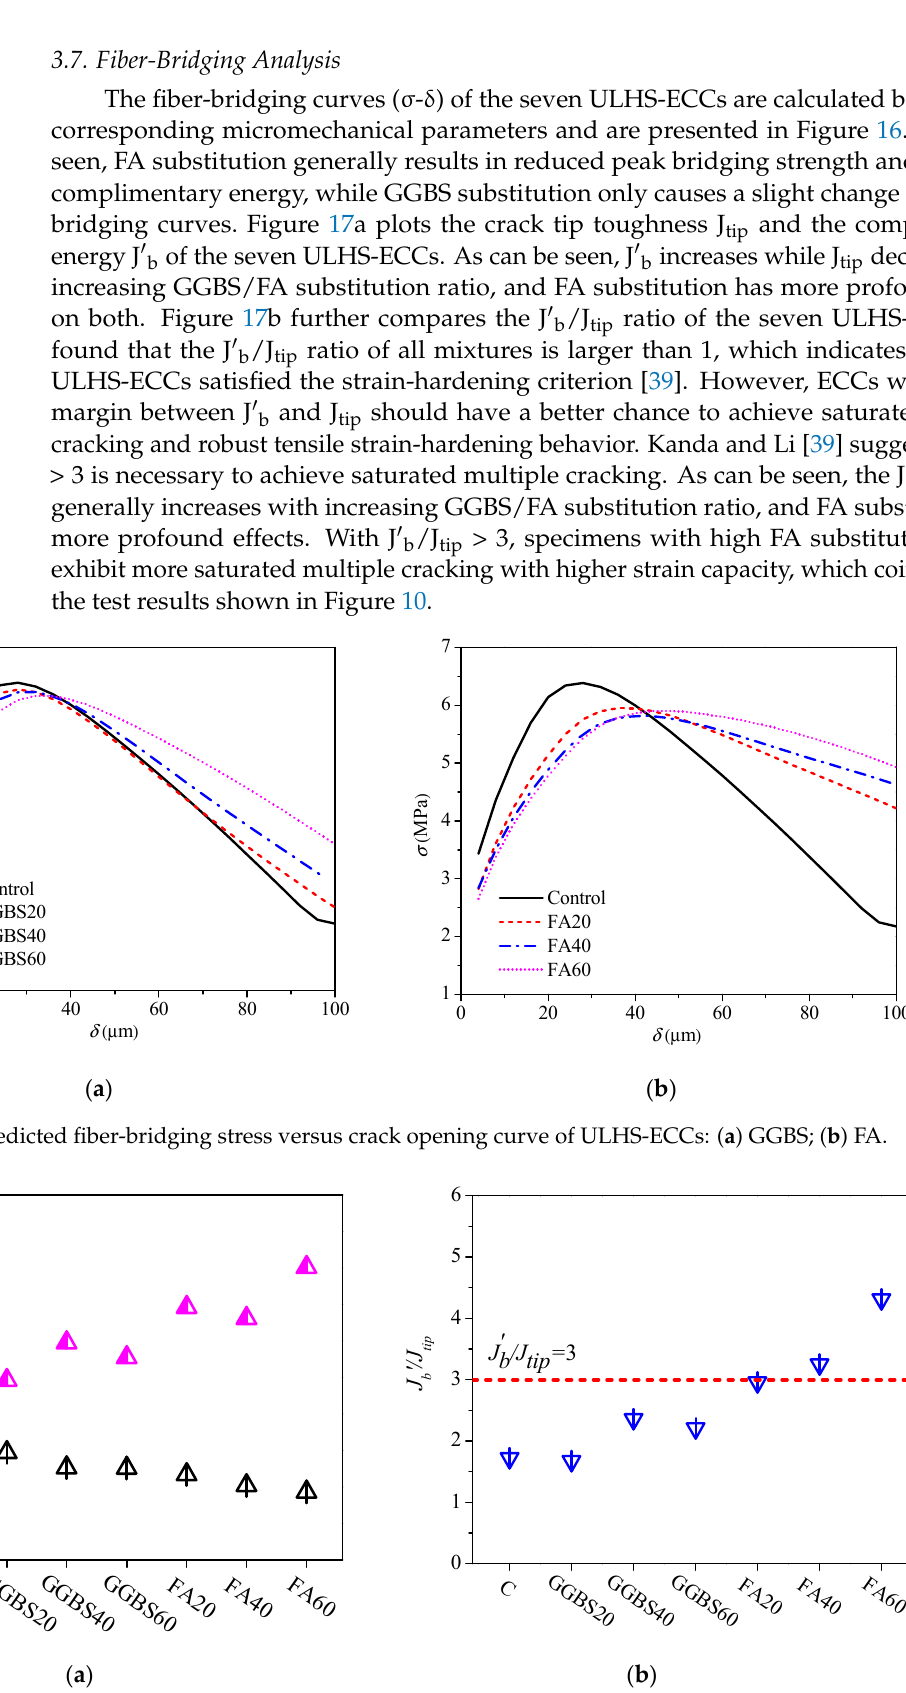
Figure 15. Matrix toughness of ULHS-ECCs as a function of dosage of SCM.